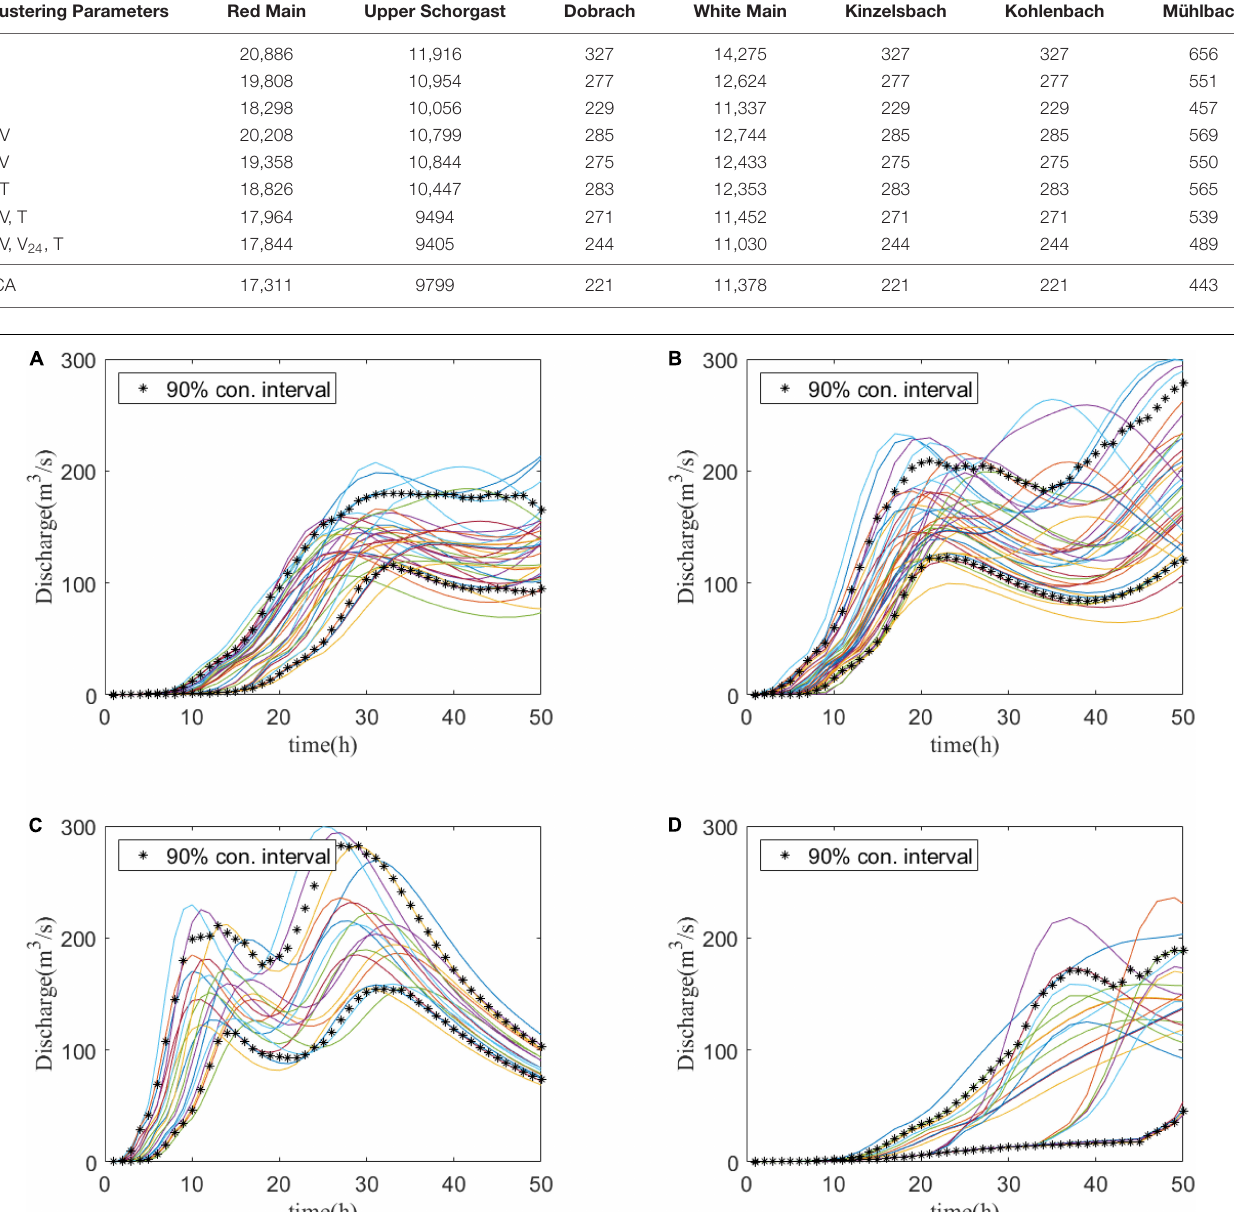
TABLE 3 | Integral of the bandwidth (90% confidence interval shown in Figure 9 ) by conventional FCM and PCA-FCM assuming a cluster number equal to 4. Clustering Parameters